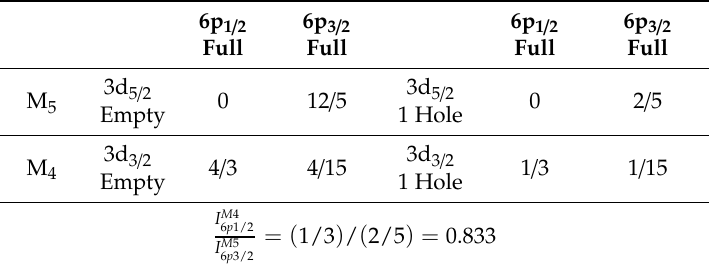
Table 4. Shown here are the 6p electric dipole. Note that (1) the total 6p cross section is 4; and (2) the 6p cross section per 3d hole is 2/5. Leftmost are the results for completely empty 3d states. Rightmost are the cross sections per 3d hole. See text for details.